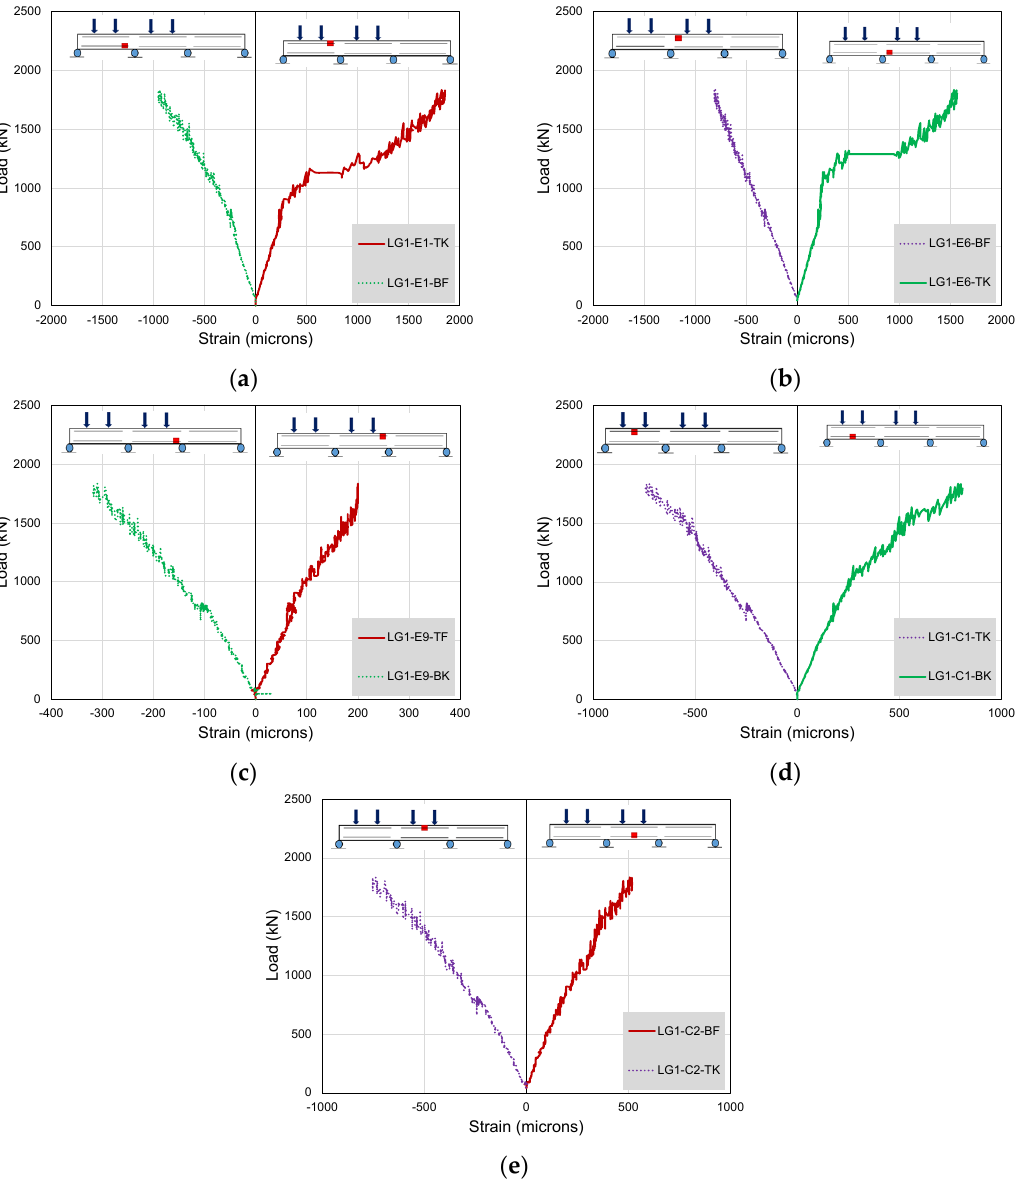
Figure 18. Strain versus load responses at locations ( a ) E1–E3, ( b ) E4–E6, and ( c ) E7–E9, ( d ) C1, and ( e ) C2.